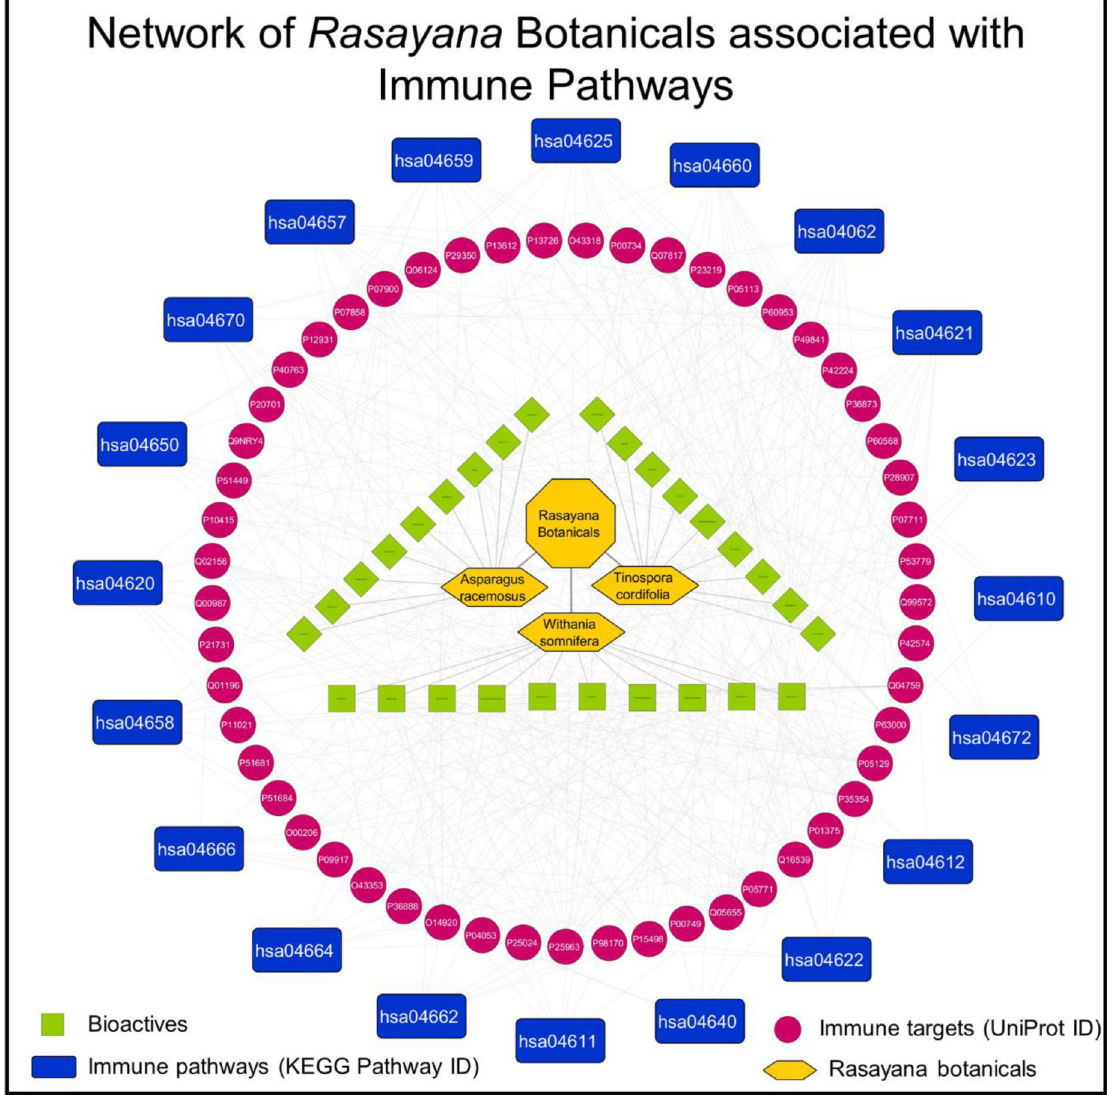
Fig 10. Network of Rasayana botanicals associated with immune pathways. Figure depicts potential mechanism of Rasayana botanicals to modulate several immune pathways through bioactive-target associations. (Fig 12A). The S1 pocket is characterized with the presence of His163, Glu166, S2 with Cys145 and S3 is known as the aromatic wheel and includes Phe181 and His41. Thus, in our studies we placed the docking grid over the S1-S3 pocket. Initially, the co-crystallized ligand was separated and docked to check if Autodock was able to reproduce the binding mode. The docked pose showed an RMSD of 0.46 Å with the crystal structure pose and a docking score of -6.2 kcal/mol (Fig 12A and 12B). A detailed study of interactions revealed that the carbonyl group of Z31792168shows a H-bond with Glu166 in the S1 pocket. The cyclohexyl moiety of the ligand has hydrophobic interactions with Met165, His41, His164, Arg188 and Gln189 residue in the S3 pocket. The pyridine ring scaffold shows hydrophobic interactions with Phe140 and His163 in the S1 pocket. All these interactions are in line with the crystallographic pose.